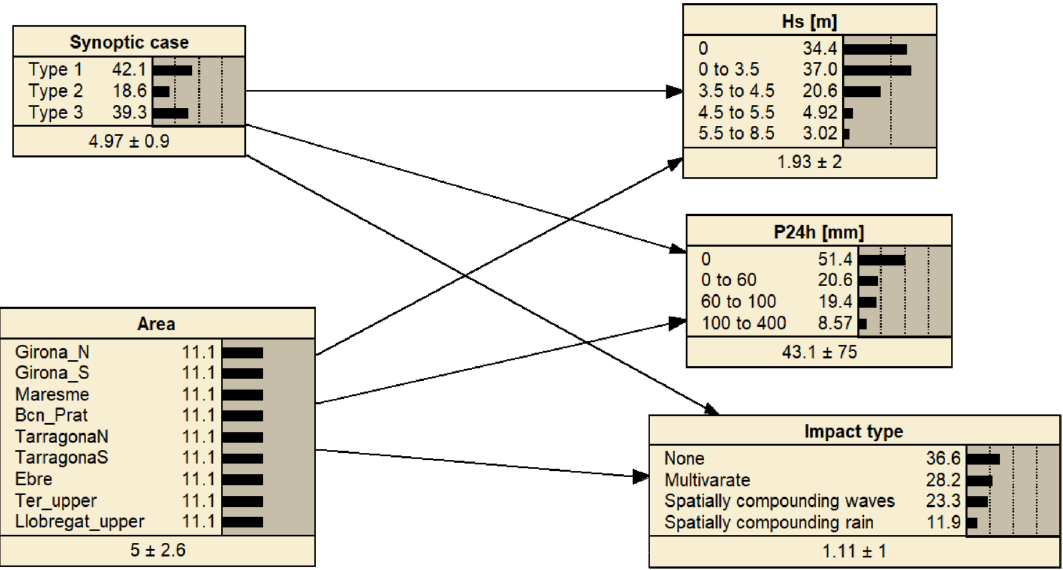
Figure 4. BN configuration used to characterize the system behaviour. The severity of the compounding forcing ( H s and P24h) and the presence of multivariate or spatially compounding (wave or rain only) effects are conditioned to the synoptic case (weather type) and area (basin/coastal